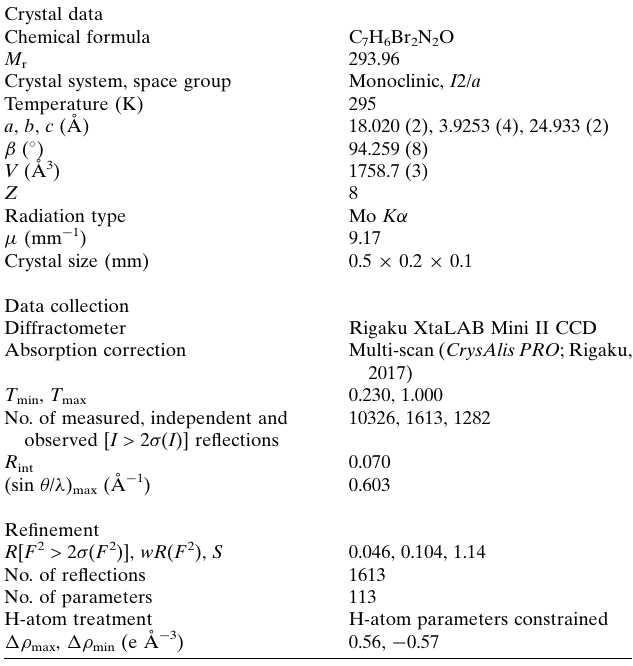
Table 2 Experimental details.